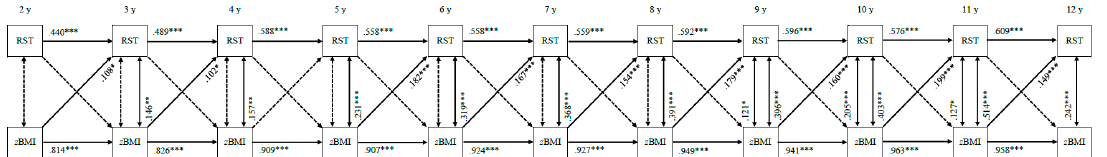
Figure 2. Bi-directional associations between restrictive feeding and standardized child body mass